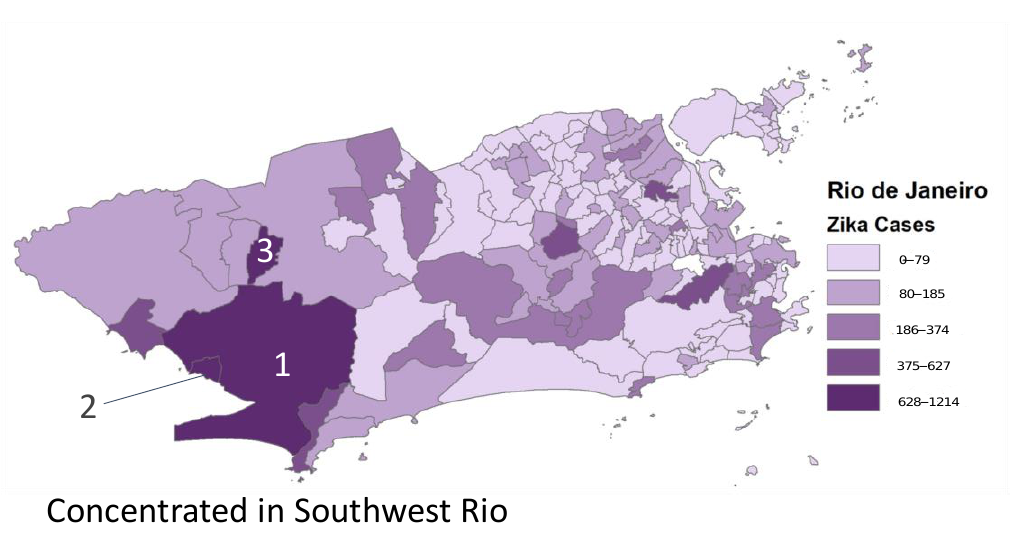
Figure 2. Zika Cases within Rio de Janeiro, 2016 – 2017. Figure 3 showcases the sub-municipal incidence of Zika cases in one municipality, Rio de Janeiro, to demonstrate the granularity of our unique dataset and its added value for other researchers. Figure 3. Zika Incidence in Rio de Janeiro, 2016 – 2017.